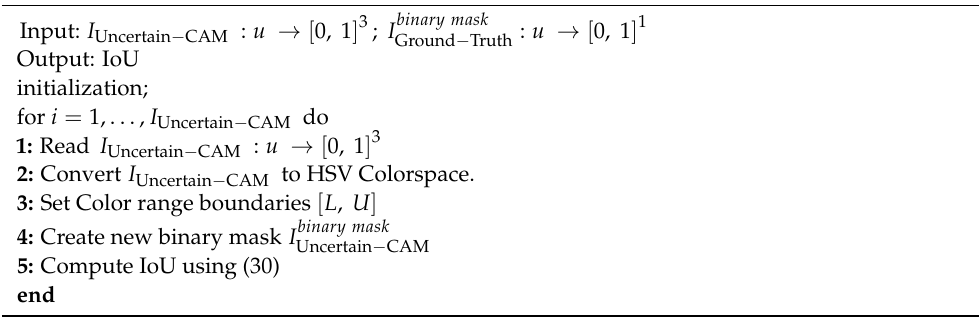
Algorithm 2: Uncertain-CAM evaluation